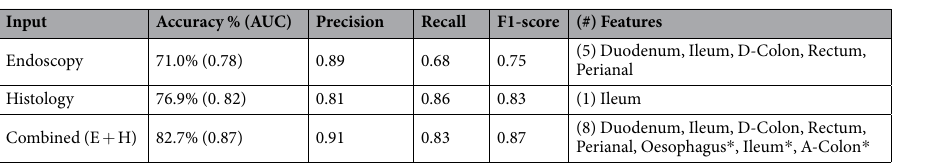
Table 2. Performance of the three optimised supervised models, asterisks indicate histological features. All metrics represent the average over the 5-folds of the cross